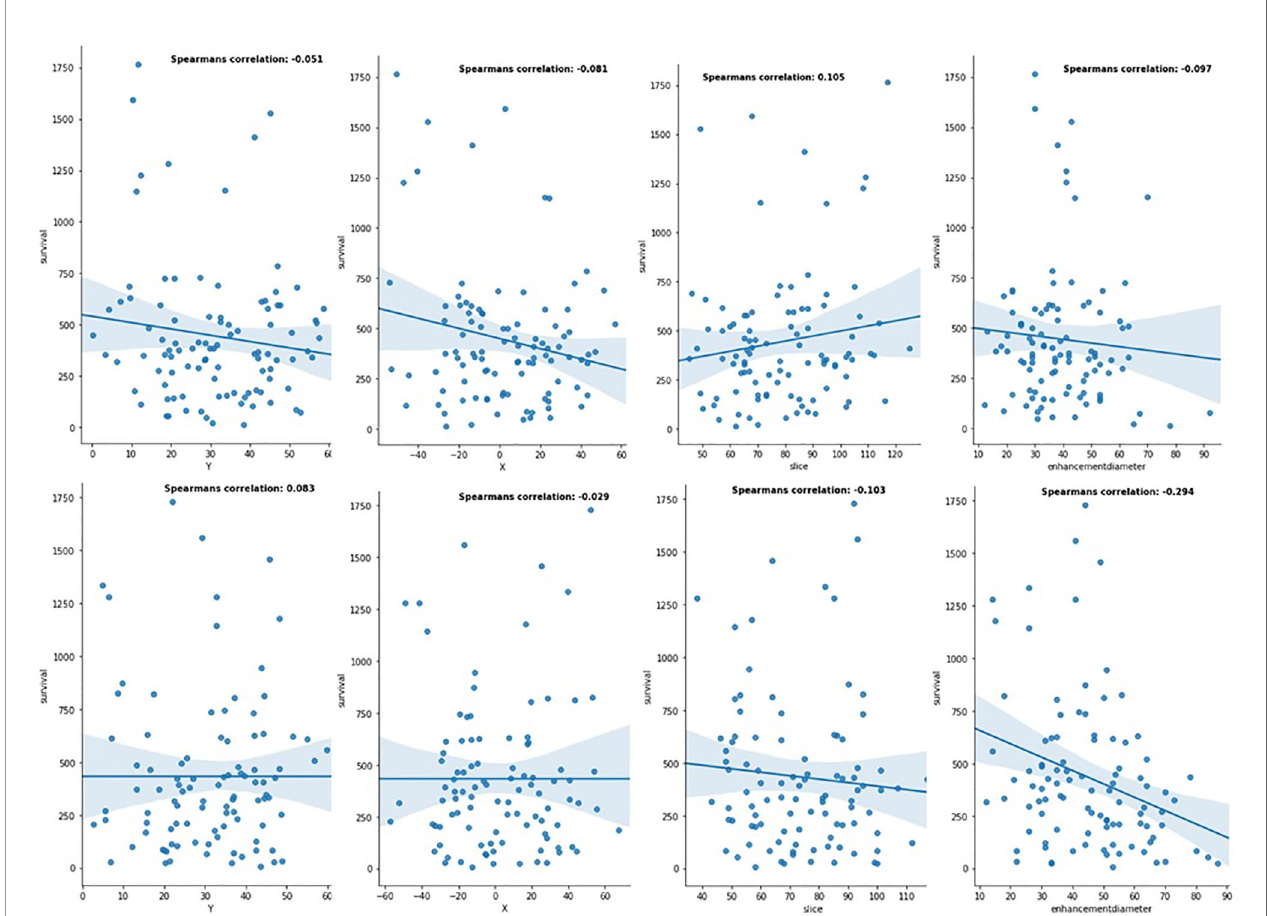
FIGURE 5 | Linear relationship between location-based features and patients' OS in the different resection status (the fi rst row is for patients with GTR resection status, and the second row is for patients with NA resection